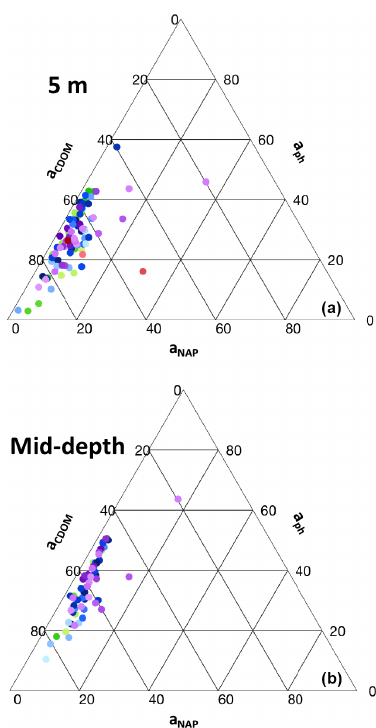
Figure 4. Ternary plots of the contribution of CDOM, non-algal particles, and phytoplankton to total non-water absorption at 443nm from discrete water samples taken at 5m (a) and mid-depth (b) . The markers are colored by year and shaded by longitude as in Fig. 1. The system is CDOM dominated, especially near the surface; phy- toplankton contributed more than 50% in only two cases for the entire